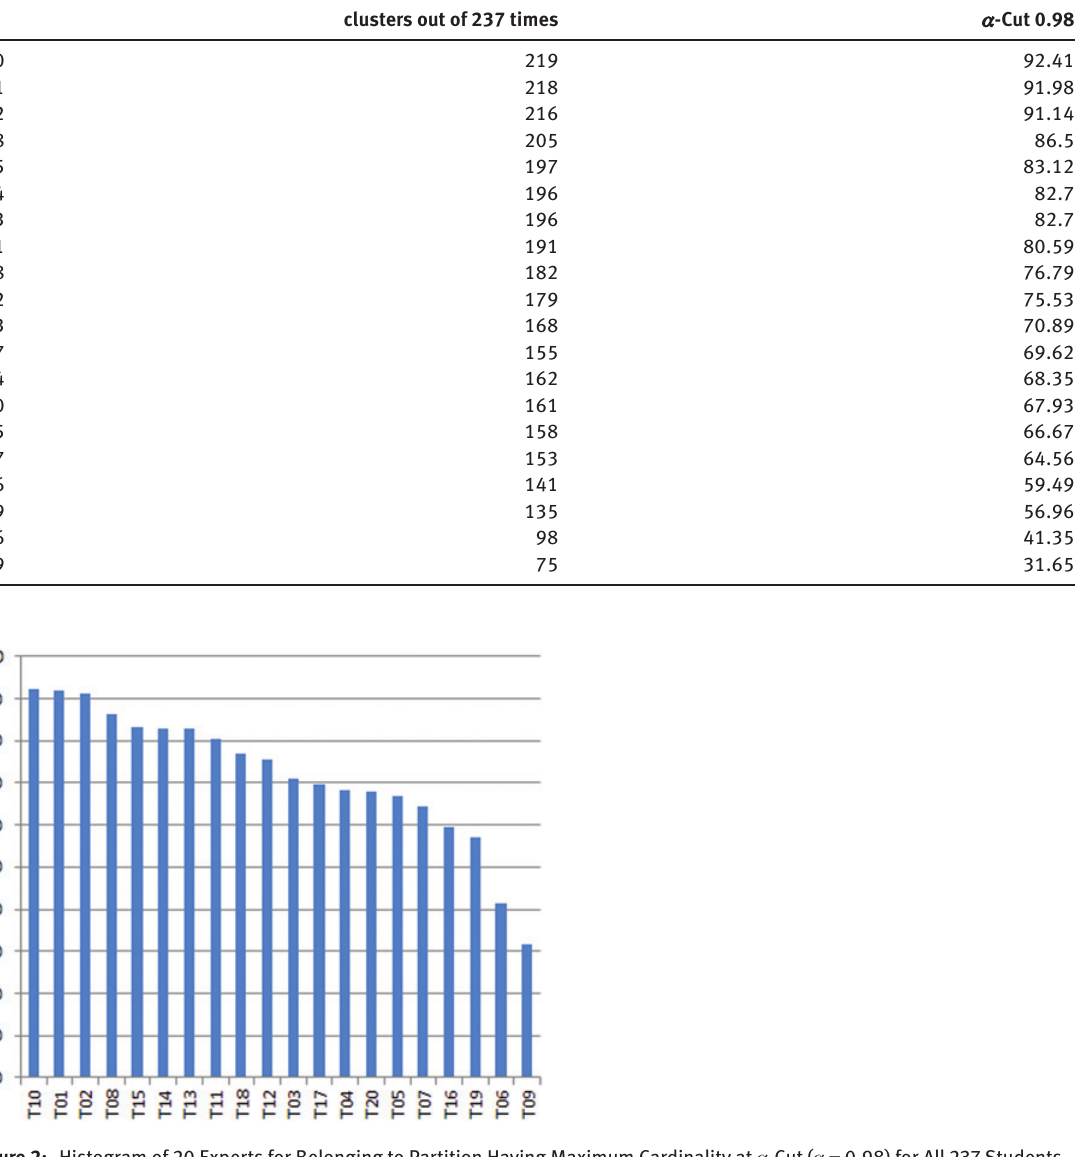
Figure 2: Histogram of 20 Experts for Belonging to Partition Having Maximum Cardinality at α -Cut ( α = 0.98) for All 237 Students.